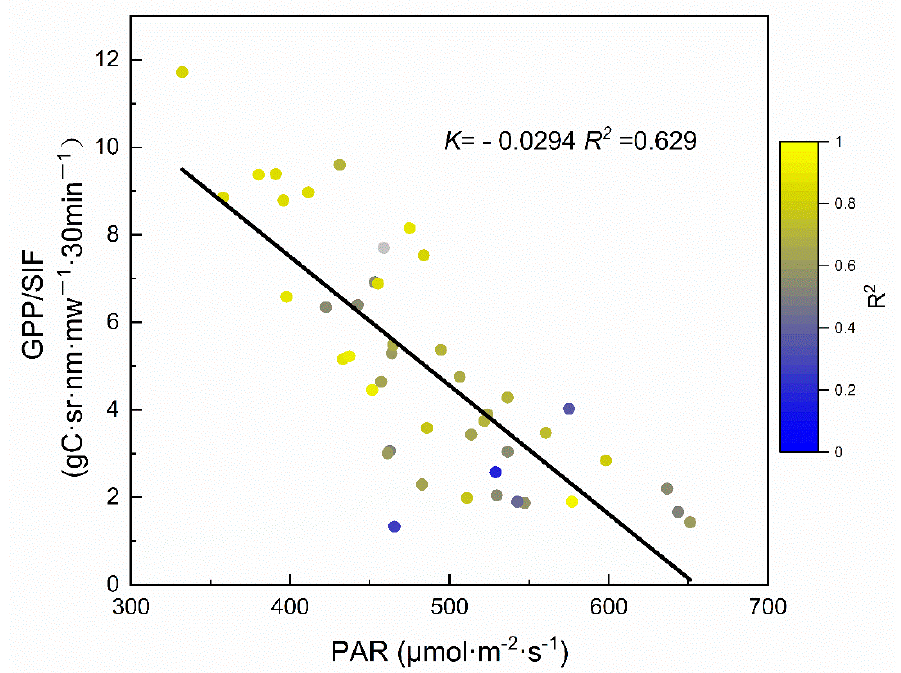
Figure 4. Relationships between the daily slopes of the linear regressions between SIF and GPP symbolized by GPP/SIF in 30 min timescale and daily mean PAR. The black line is linear regression, K and R 2 represent the slope and coefficient of determination of linear regression, respectively. The color bar on the right on behalf of the R 2 of the linear regressions in every single day. All data are for sunny days only.